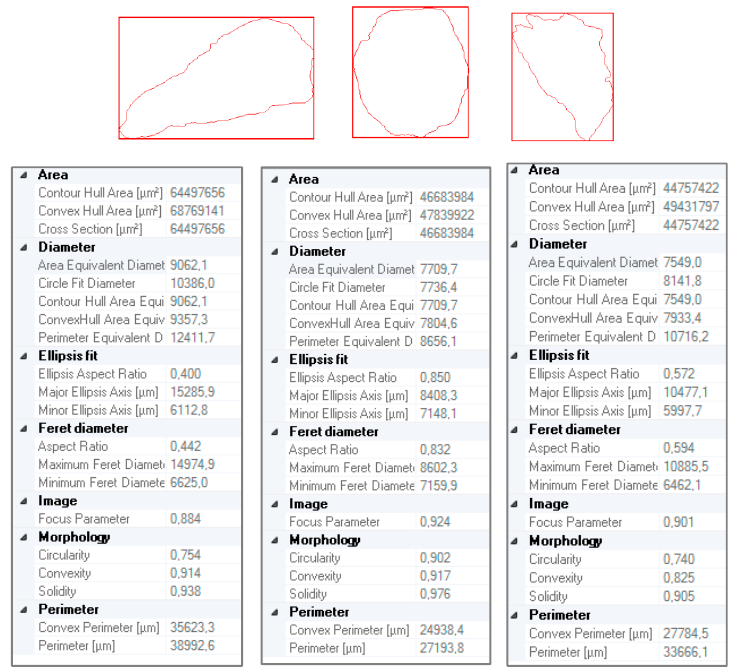
Figure 9. List of determined geometrical parameters for selected regular particles of chalcedonite.